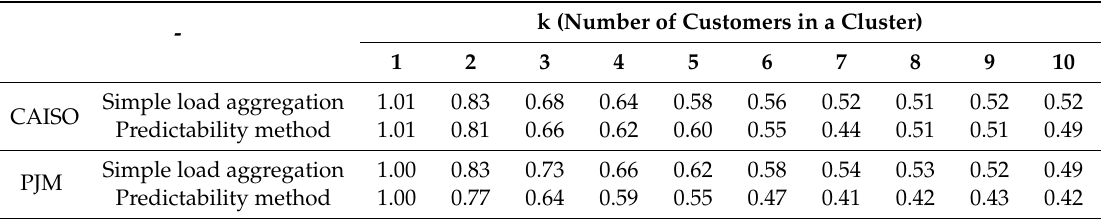
Table 10. MAE for simple load aggregation and the predictability method for CAISO and PJM CBL estimation